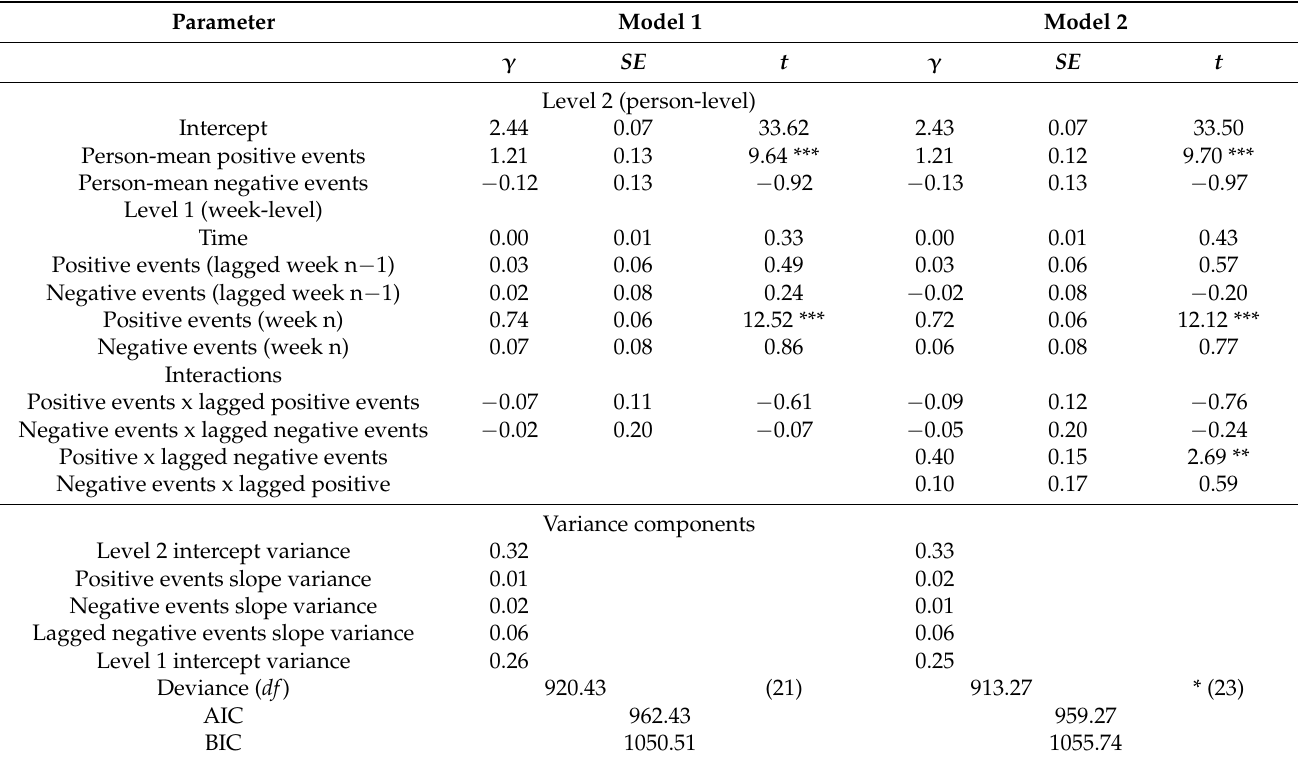
Table 3. Results from Multilevel Analysis Predicting Work